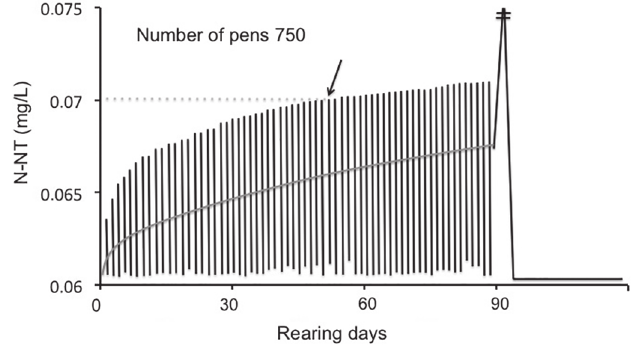
Figure 5 - Effect of the installation of 750 pen enclosures at the Porto do Rei bay on the total nitrogen concentration assuming a current velocity of 0.01m s -1 and a net clogging effect of